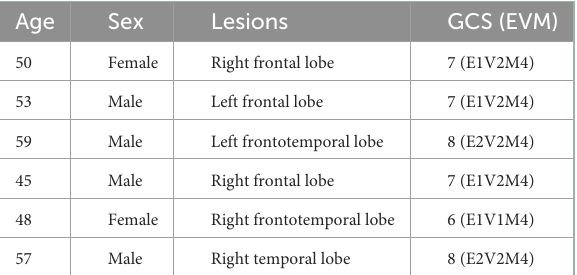
TABLE 1 Clinical data of six patients with severe